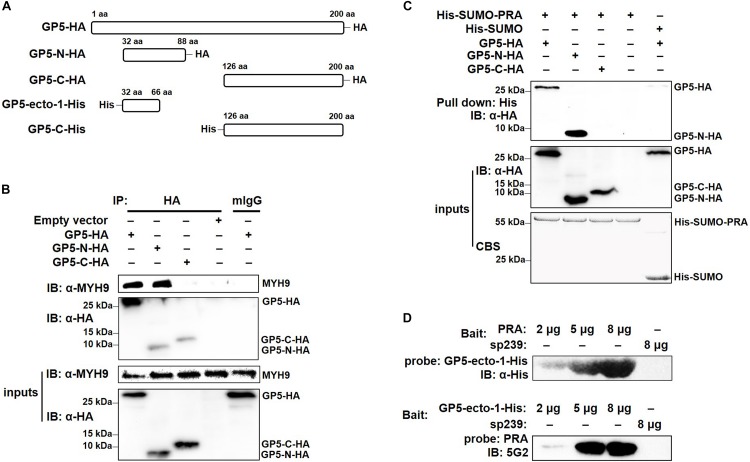
The first ectodomain of GP5 interacts with PRA. (A) Schematic diagram of different fragments of GP5. (B) Co-IP analysis for interaction between different GP5 domains with endogenous MYH9. Lysates of MARC-145 cells transfected with plasmids encoding GP5-HA, GP5-N-HA, and GP5-C-HA were subjected to Co-IP using anti-HA mAb and the immunoprecipitation were immunoblotted using anti-MYH9 polyclonal Abs and anti-HA mAb. (C) His-pull-down analysis for interaction between PRA and different GP5 domain proteins. Purified His-SUMO-PRA or His-SUMO (as a control) proteins were captured with anti-His resin and then incubated with lysates from COS7 cells transfected with plasmids encoding GP5-HA, GP5-N-HA, and GP5-C-HA. The interaction complexes were pull-downed and subjected to the SDS-PAGE and Western blot via immunoblotting using anti-HA mAb. (D) Far-western blot analysis of recombinantly expressed GP5-ecto-1 and PRA interaction. Purified PRA and GP5-ecto-1-His (2, 5, or 8 μg per lane) subjected to SDS-PAGE and transferred to PVDF membrane were probed with GP5-ecto-1-His and PRA, and then detected with anti-His mAb and Mab2-5G2, respectively. Protein sp239 was used as an irrelevant protein control.